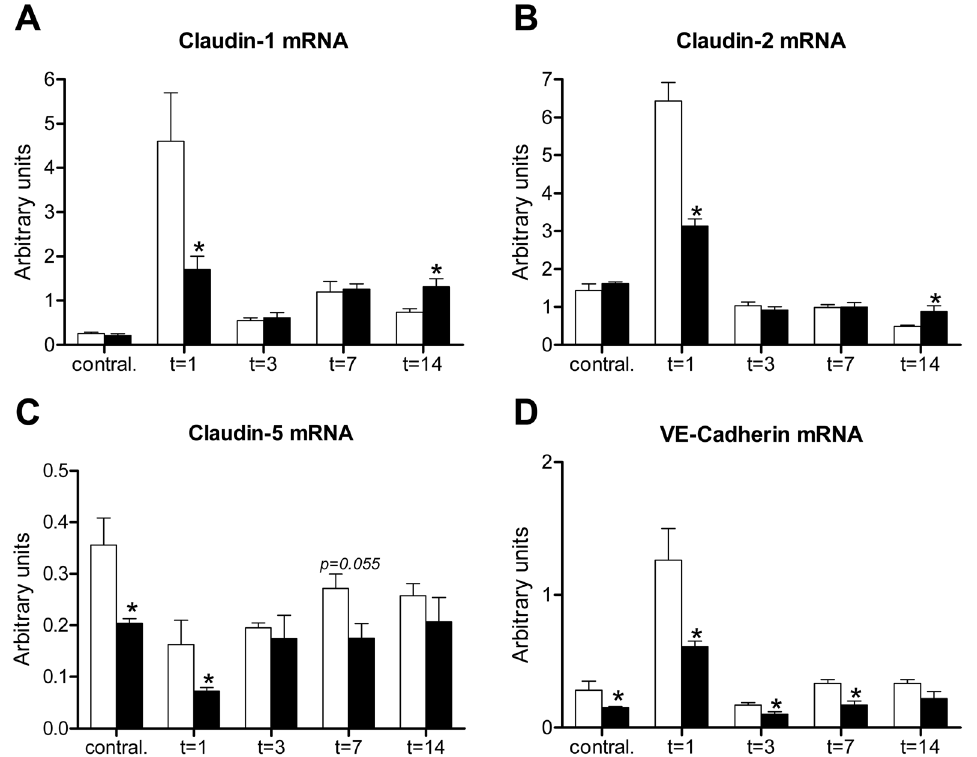
Figure 3. Nlrp3 preserves early expression of renal epithelial- and endothelial-associated Claudins following UUO. Renal mRNA expression of epithelium-associated Claudin-1 (A) and Claudin-2 (B) and vascular endothelium-associated Claudin-5 (C) and VE-Cadherin (D) was reduced in obstructed kidneys of Nlrp3 2 / 2 mice (black bars) when compared to wild type mice (white bars) 1 day post-UUO. Whereas VE-Cadherin remained lower, Nlrp3 2 / 2 mice displayed a subtle increase in Claudin-1 and -2 expression 14 days post-UUO compared to wild type mice. Contral. = contralateral kidneys of mice subjected to 14 days of UUO. Data are mean 6 SEM of 6 mice per group. *:p , 0.05.